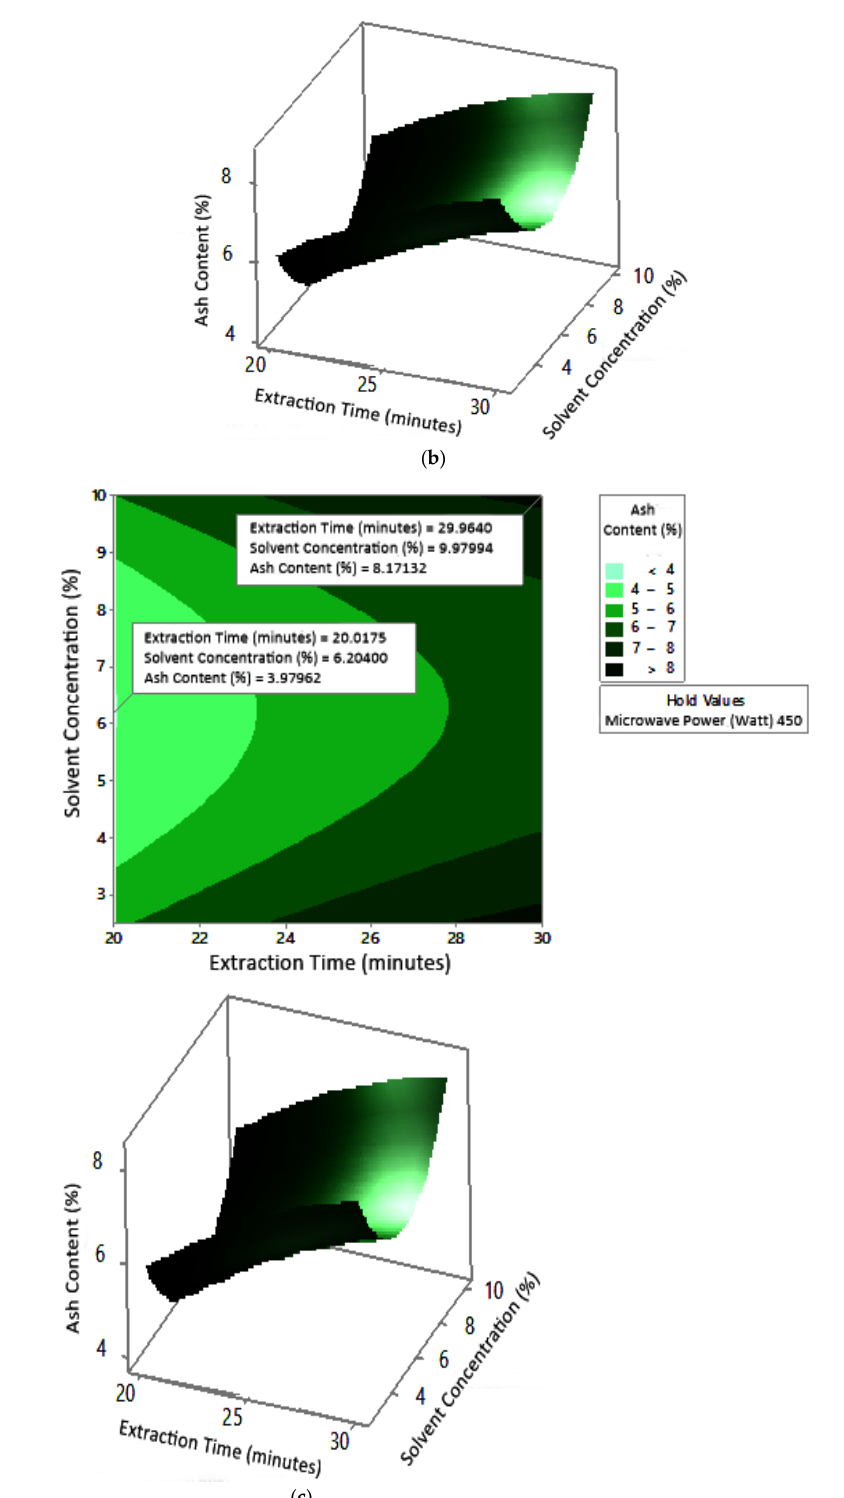
Figure 12. Effect of extraction time and solvent concentration on ash content at microwave powers: ( a ) 180 W, ( b ) 300 W, and ( c ) 450 W.